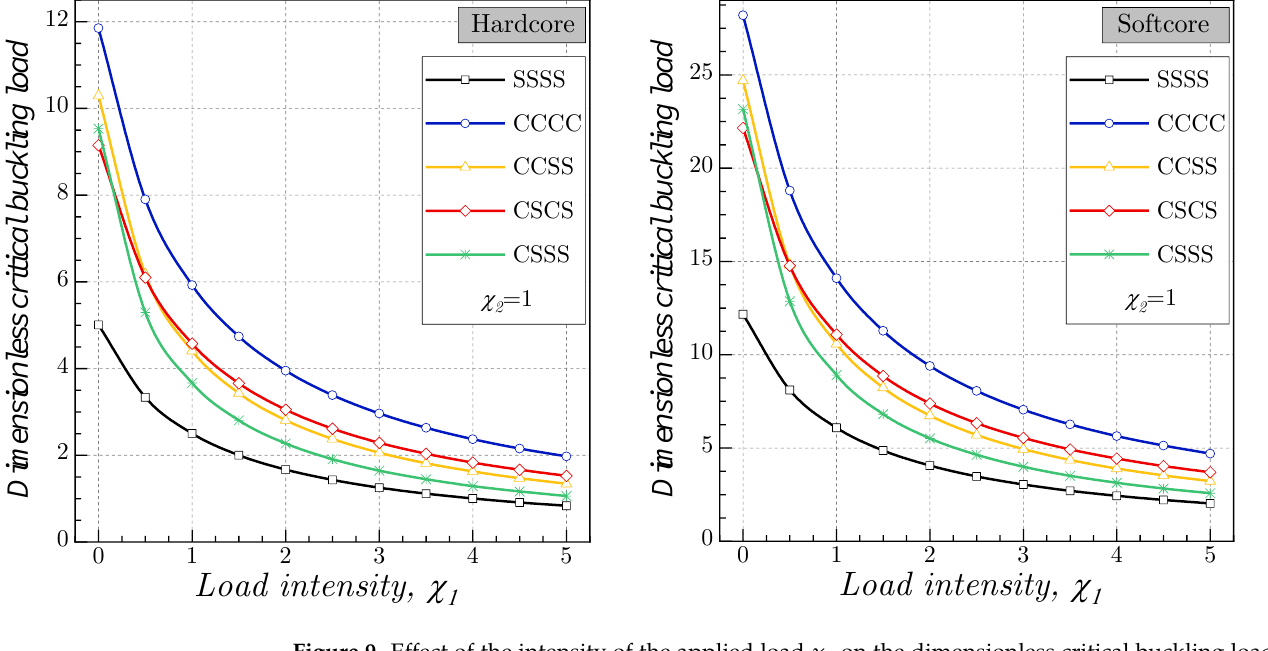
Figure 9. Effect of the intensity of the applied load χ 1 on the dimensionless critical buckling load N of tricoated FG-A shells for various boundary conditions ( R = 5, p = k = e = 2, b = a = 10 h , µ = λ = G ζ = G η = K w = 0 ) .